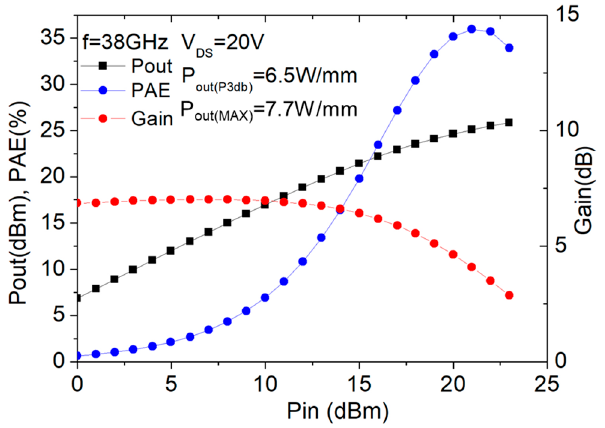
Figure 12. Large-signal performance of the device with gate width of 2 × 25 μ m at 38 GHz.